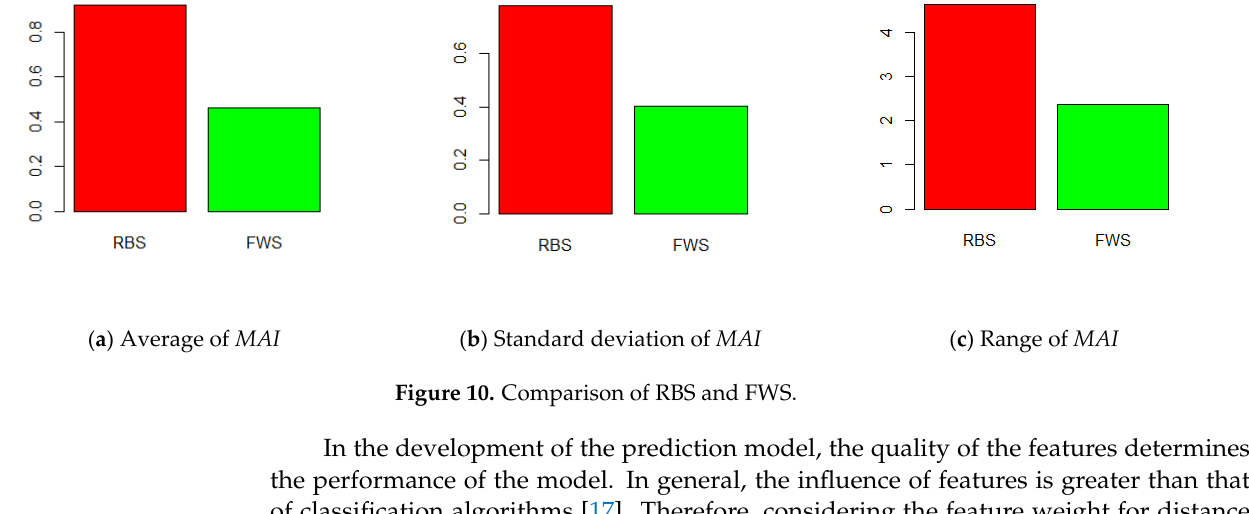
( a ) RBS ( b ) FWS. Figure 12. MAI of FWS according to number of class (K=3, bin width=hybrid).